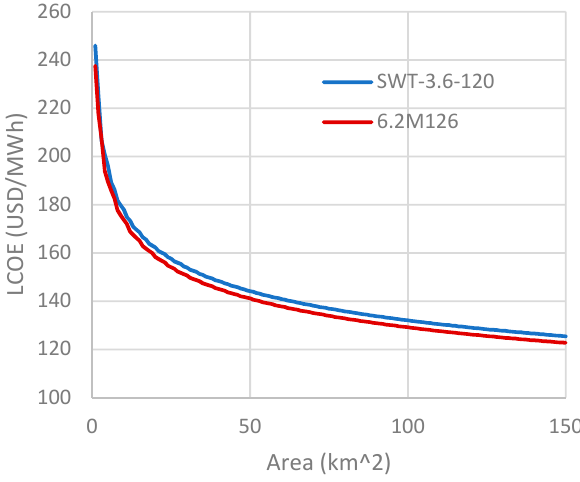
Figure 30. LCOE comparison of SWT-3.6-120 AND 6.2M126 vs. area.